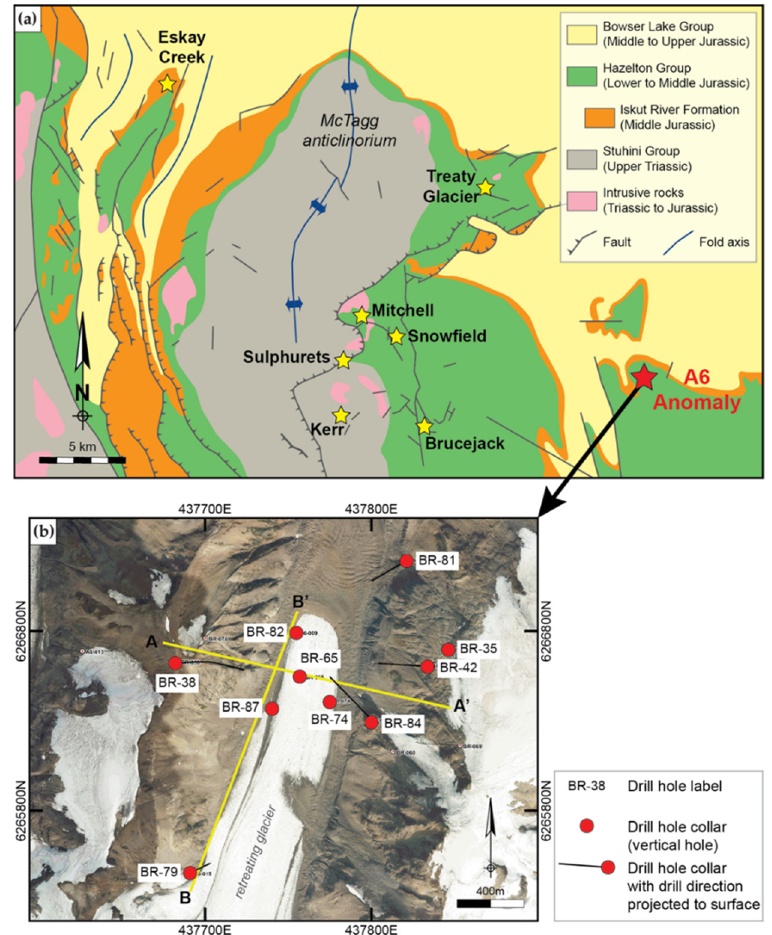
Figure 3. Geological map of study area and map of drill holes at A6 Anomaly. ( a ) Detailed geological map of Iskut River region with location of Eskay Creek, KSM, Snowfield, Brucejack, and Treaty Glacier deposits (yellow stars) and the A6 Anomaly (red star). In Map b (modified after Lewis [5] and Kirkham and Margolis [34]), the black arrow highlights ( b ) the location of drill holes at the A6 Anomaly investigated in this study; cross sections for A-A’ and B-B’ are shown in Figure 4. Their stratigraphic section of each drill hole is shown Figure 4, Easting and Northing after UTM NAD83 zone 9. Details about geographic location and depth for each drill hole are summarized in Supplementary Materials Table S1a).